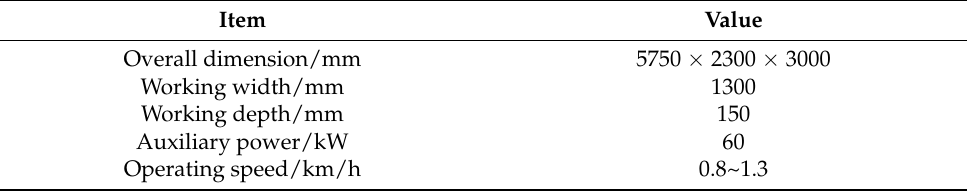
Figure 16. Experimental verification: ( a ) field experiment; ( b ) sandy soil removal process. Table 6. Tiger nut harvester parameters.